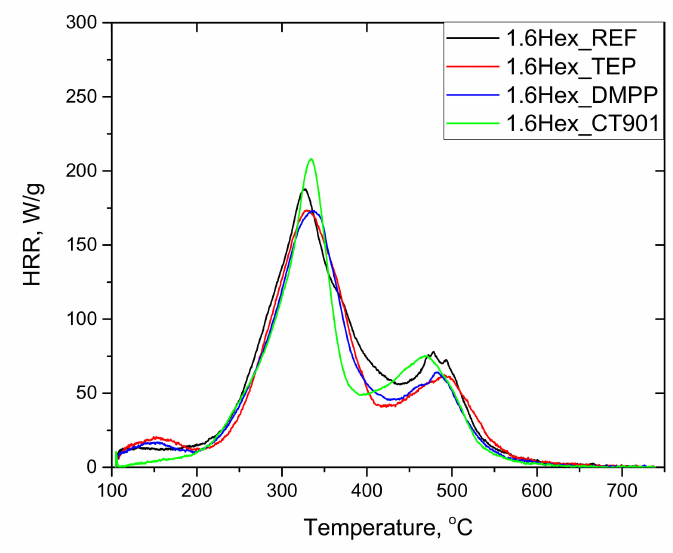
Figure 10. HRR curves of rigid polyurethane foams with 40 wt.%